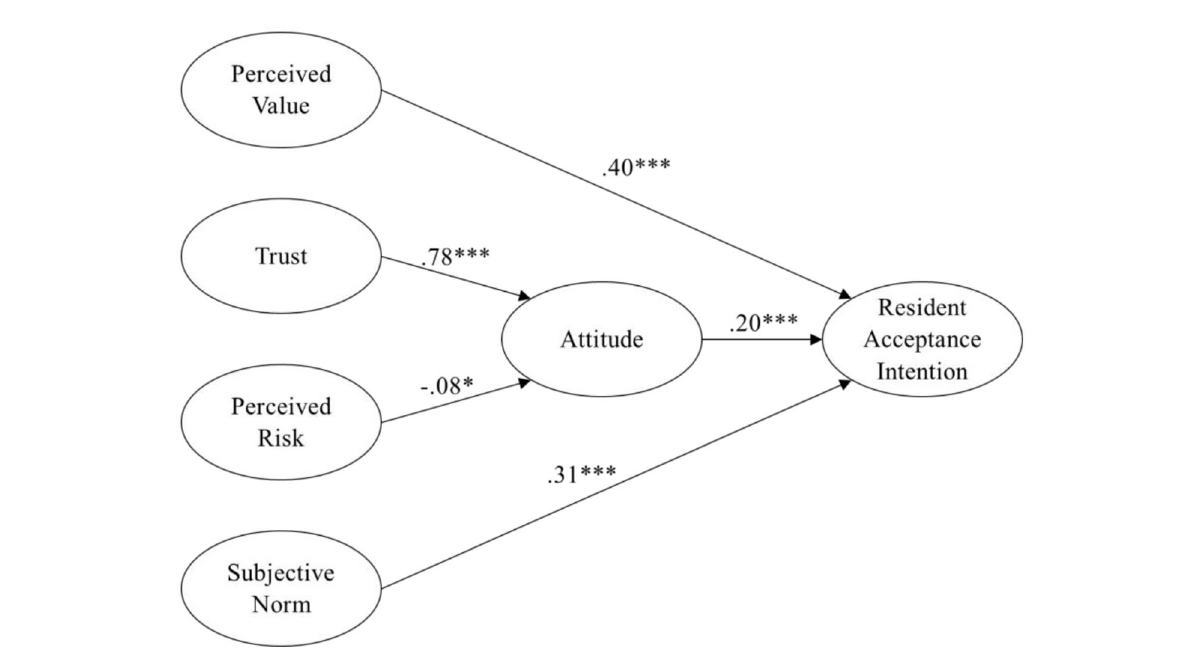
FIGURE2 Statistical model with parameter estimates. * p < 0.05, *** p <